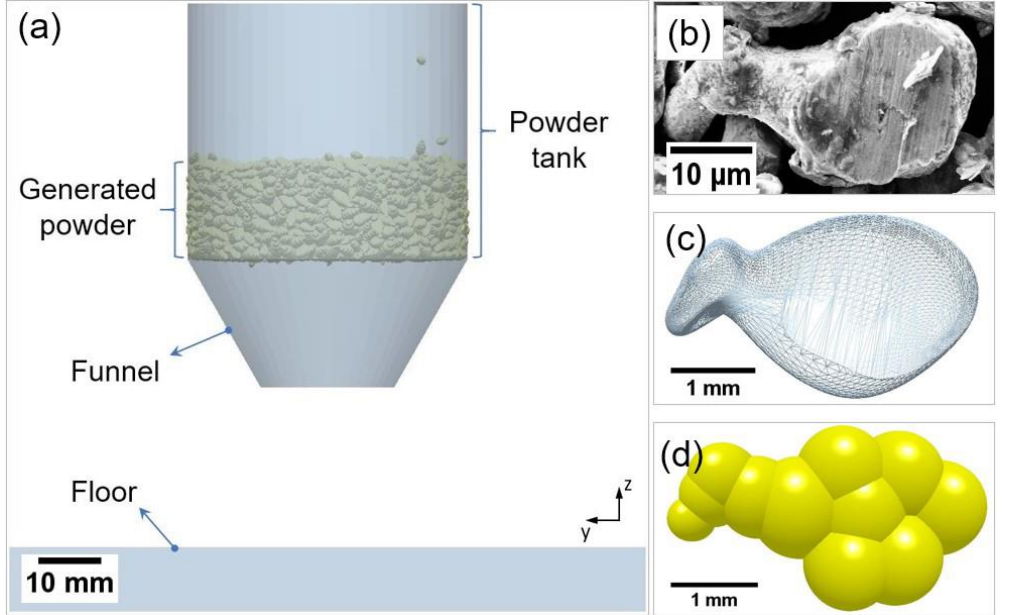
Figure 2. Projection of ( a ) simulation model with an example of ( b ) SEM image of the 0.5 h milled powder, ( c ) created a 3D template based on the SEM images of the real powder and ( d ) created DEM particle with 11 spherical cells from the template.